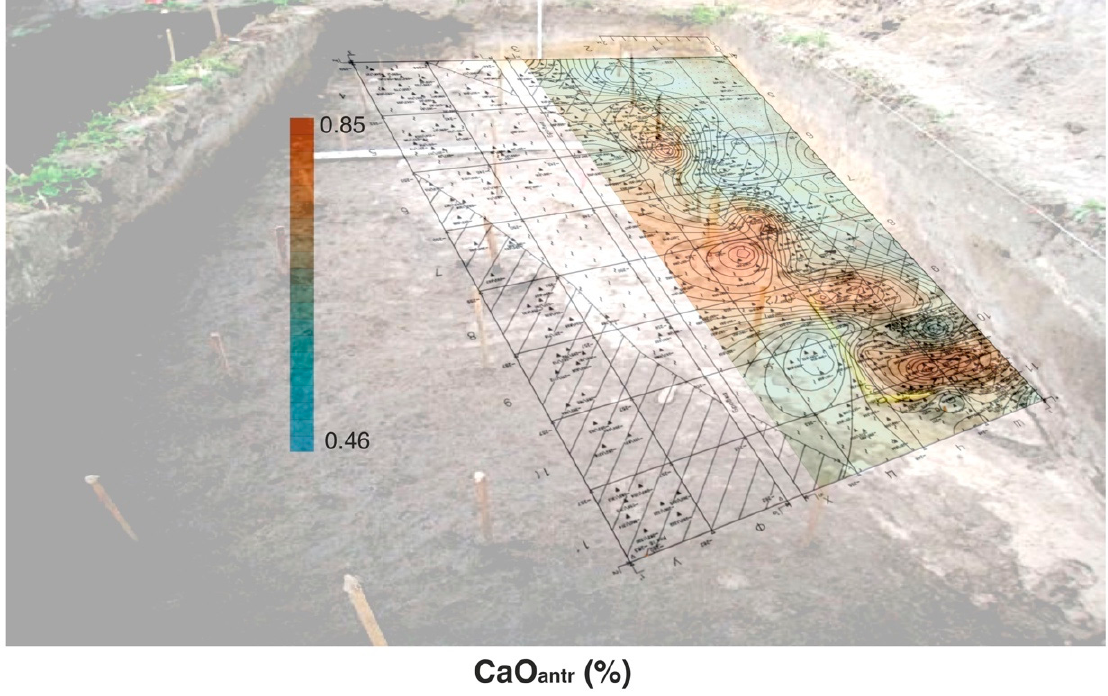
Figure 8. Geochemical maps of CaO anthr distributions in sediments on the surface of the cultural layer at the Podolye 1 site [38], designed by M.Kulkova.